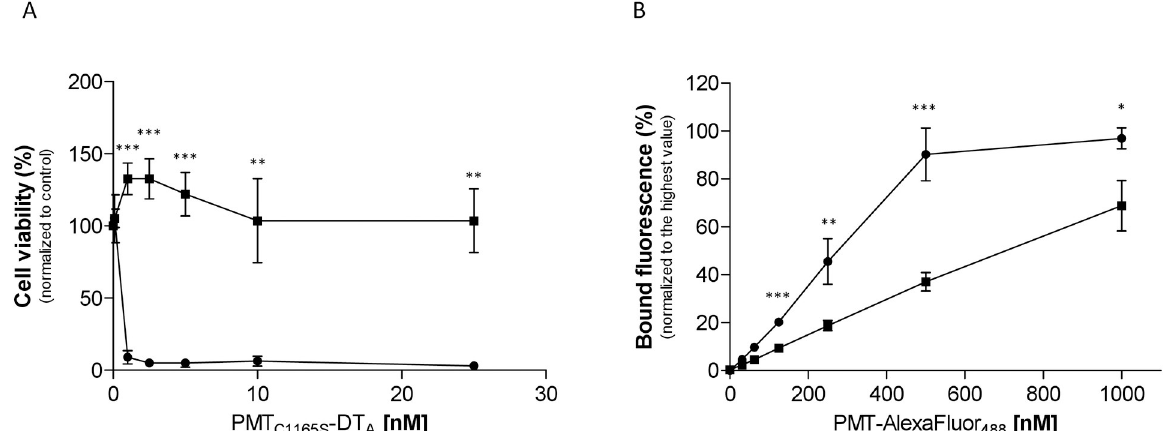
Fig 3. LRP1 knockout prohibits binding and uptake of PMT. MEF (circles) and MEF-LRP1 -/- cells (squares), respectively were incubated with increasing concentrations of PMT(C1165S)DTa for 48h and cell viability was analyzed as % of untreated controls. Shown is the mean of three independent experiments (A). Cells were incubated with increasing concentrations of Alexa488 labeled PMT (PMT 488 ), washed and bound fluorescence analyzed by FACS shown as mean of three independent experiments (B).